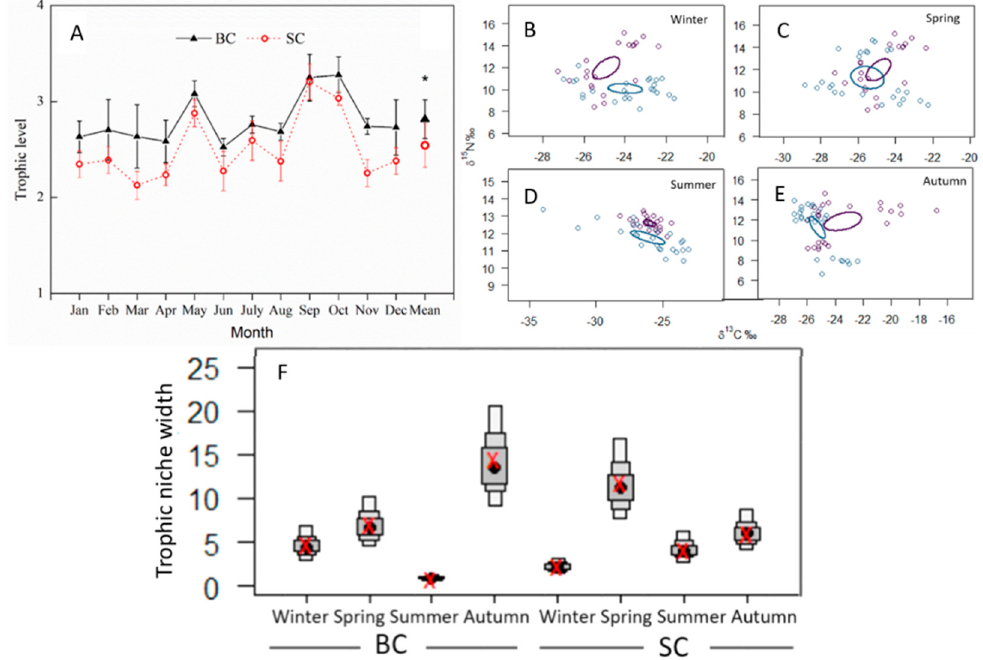
Figure 2. Seasonal variations of trophic patterns of silver carp (SC) and bighead carp (BC). Asterisks denote significance at the p < 0.05 level. ( A ) is the trophic level of two fish species. ( B – E ) indicate isotopic niche width marked with the standard ellipse area corrected for small sample sizes (SEAC) for bighead carp (purple empty circles) and silver carp (blue empty circles) in winter, spring, summer and autumn, respectively. ( F ) represents the trophic niche width of the two fish species in different seasons.